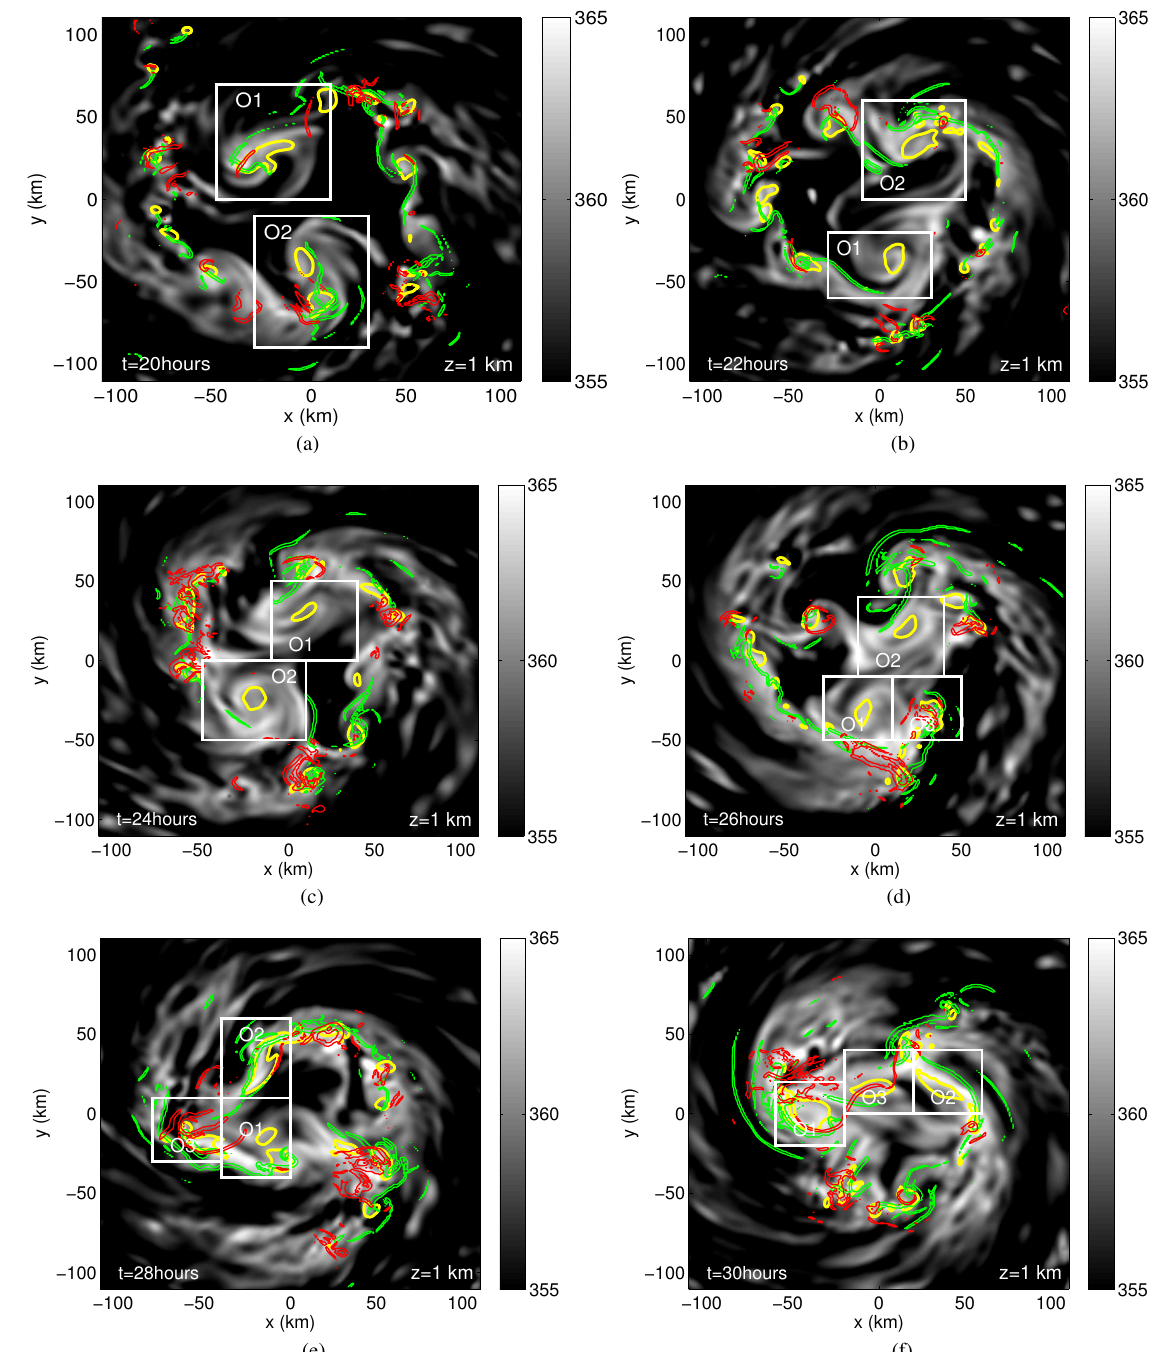
Fig. 14. Mixing regimes can be seen in labeled boxes containing FTLE LCSs at z=1 km with 1 hour integration time at times from 20 hours to 30 hours every 2 hours. The attracting LCSs (green), repelling LCSs (red), and vorticity contours (yellow) are all overlaid on the θ e field (black and white shading).